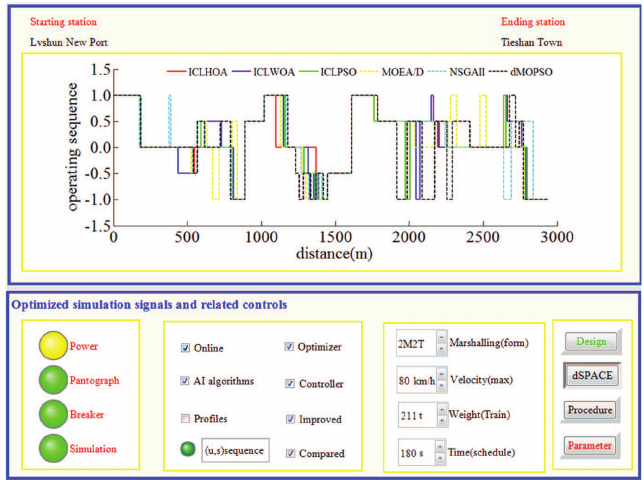
Figure 24. The control sequence distance curve obtained by different algorithms in